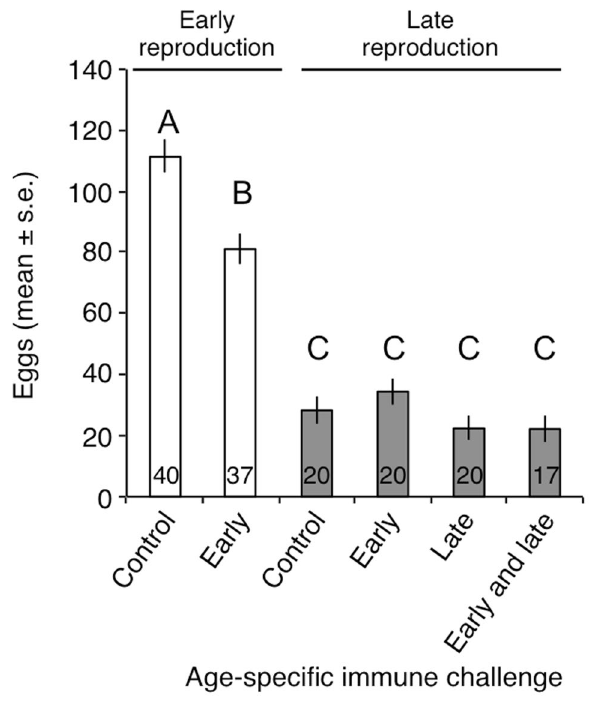
Figure 2. Mean number of eggs (± s.e.) produced by females early in life (young: between day 10 and day 30 post eclosion) and late in life (old: between day 40 and day 60 post eclosion) as function of their life time immune treatment: control, immune challenged early only (early), immune challenged late only (late) and immune challenged both early and late in life (early and late). The numbers at the bottom of the bars are the sample size (the number of females involved). Bars topped with the same capital letters denoted groups with non-significant differences (see Table